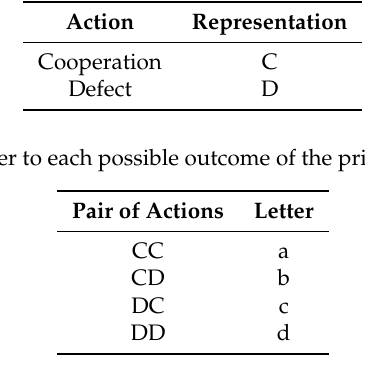
Table 3. Representation of actions using letters.